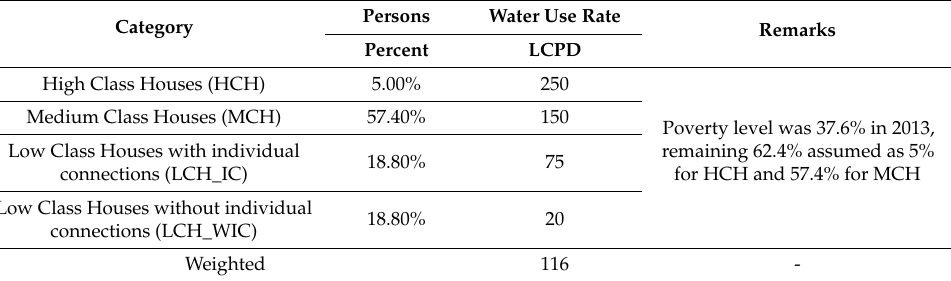
Table 2. Domestic water use rates for Mombasa City.